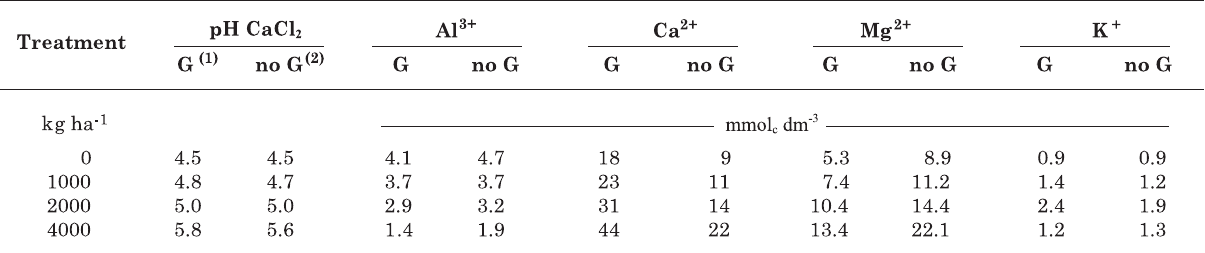
Table 1. Chemical soil analysis of samples collected in the 0–20 cm layer, 24 months after lime and gypsum surface